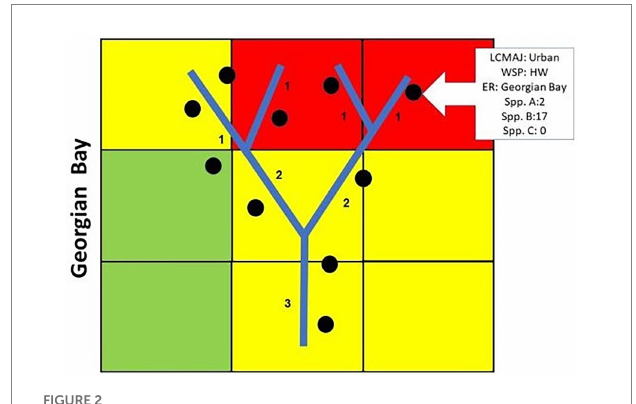
FIGURE 2 Schematic demonstrating how both Strahler stream order and